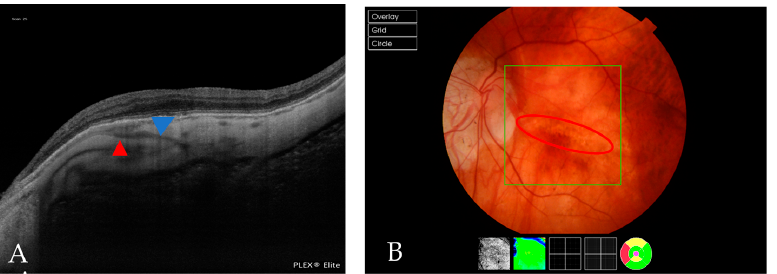
a spot > 3 mm from the fovea.